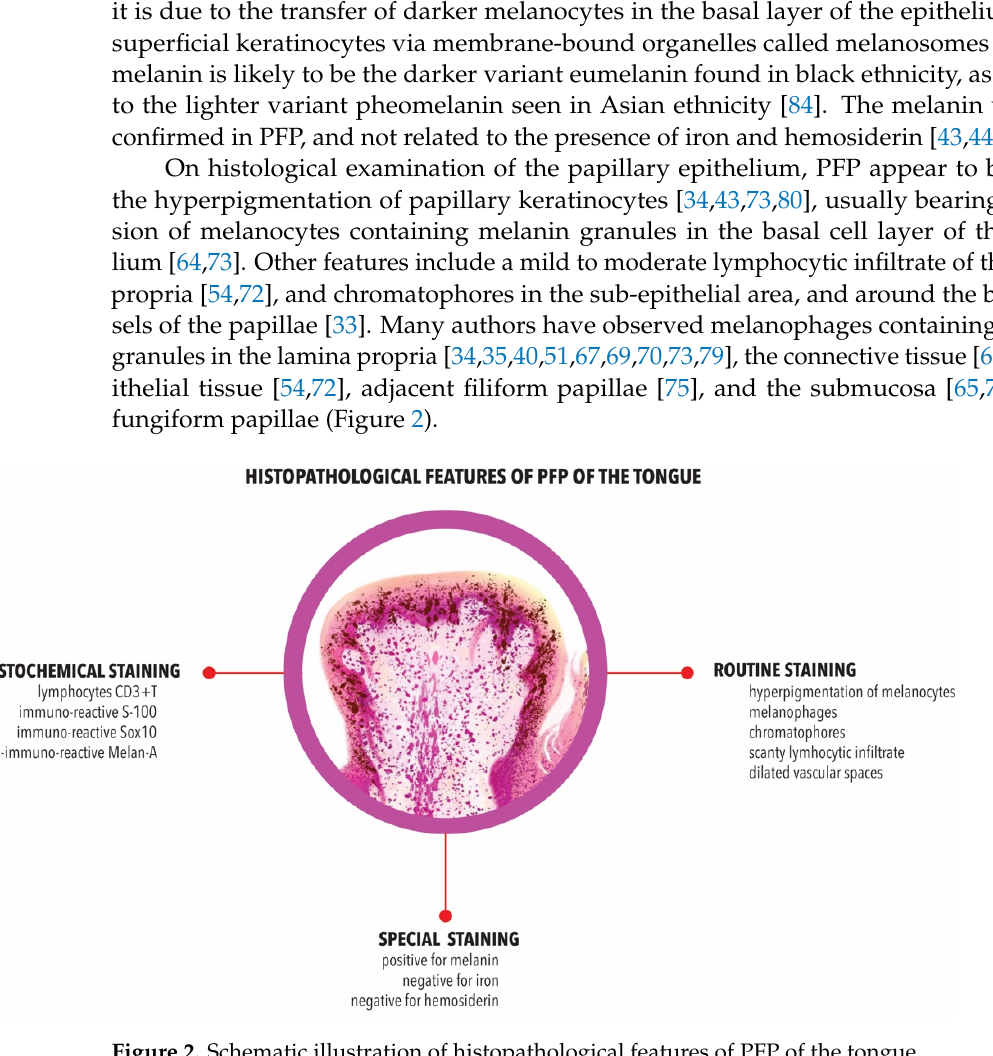
Figure 2. Schematic illustration of histopathological features of PFP of the tongue. Melanophages—macrophages that contain melanin—are a common feature in in ‐ flammatory and non ‐ inflammatory pigmentation [85]. Melanophages are large cells with indistinct cytoplasmic boundaries, usually located around or near superficial dermal ves ‐ sels [73]. Another histological feature described by some authors in PFP is the presence of so ‐ called ‘chromatophores’, a disputed, and confusing term used by Holzwanger [33,71] and Koplon [71] in the older literature, referring to melanocytes, or perhaps more proba ‐ bly to melanophages (pigment carrying cells) as mentioned by Steigmann [86]. The pres ‐ ence of melanin was later confirmed with Fontana–Masson staining [44]. The presence of a lymphocytic infiltrate reported in some studies, could be consid ‐ ered as a sign of an inflammatory response associated with the genesis of PFP. In an im ‐ munohistochemical study, Ghigliotti et al. revealed that the lymphocytes in PFP were mainly CD3 + T lymphocytes [72]. The localised traumatic event or mechanical injury pro ‐ vokes inflammatory responses. The inflammatory responses cause inflammatory cytokine production from keratinocytes as well as from fibroblasts, which in turn stimulate mela ‐ nocytes, often resulting in pigmentation. In some research, it has been mentioned that several cytokines such as interleukin, tumor necrosis factor (TNF), and prostaglandin E (PGE) modulate the proliferation and differentiation of human melanocytes to pigmenta ‐ tion [87]. The presence of the latter lymphocytic infiltrate, together with the mel ‐ anophages, implies the possibility that the pigmentation is due to an inflammatory pro ‐ cess, provoked most likely by a localised traumatic event (Figure 2). Not surprisingly, some authors have investigated whether PFP is a precursor of mel ‐ anoma. To our knowledge, no malignant transformation has been reported from PFP. Only in two studies were immunohistochemical staining for melanotic markers done, de ‐ tecting Sox10 [43] and S ‐ 100 [75] expressions, but they were non ‐ reactive for melan ‐ A [75]. On further detailed review of the reports, we noted that a number of investigators have used dermoscopy to evaluate the nature of PFP. This technique increases the sensi ‐ tivity and specificity of the clinical examination, and almost eliminates biopsy procedures and by extension reduces patient discomfort. Nevertheless, dermoscopy is infrequently used in dentistry [88]. A majority of clinicians in our review used dermoscopy, but in combination with biopsy examination, which seems to be a waste of resources [34,35,64,65,67,72,80].